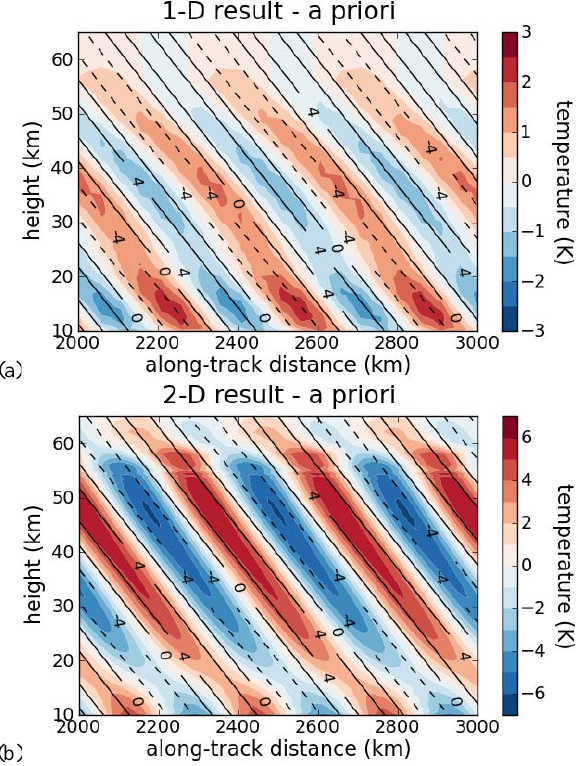
Fig. 13. This shows the retrieval result for (a) a series of conven- tional 1-D retrievals on the left and (b) a 2-D retrieval in the middle for a wave with 30km vertical and 320km horizontal wavelength. Please note the different color mapping. The climatological back- ground profile was subtracted from the result. A contour plot for the difference between the true modulated wave structure and the a priori has been included as black lines to visualize the phase shift of the 1-D retrieval.